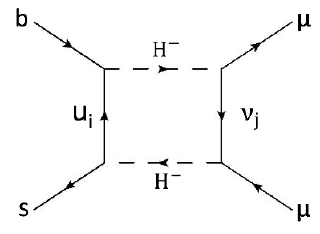
Figure 7 . Diagram that contributes to the B ! K(cid:22)(cid:22) in case (B) and case ( C